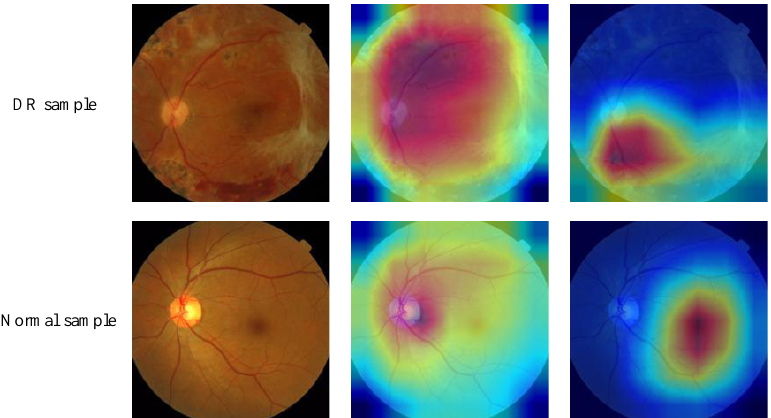
Figure 3. The highlighted regions of the DR decision. From the left to right: the input, highlighting without CAM-Attention and highlighting with CAM-Attention.